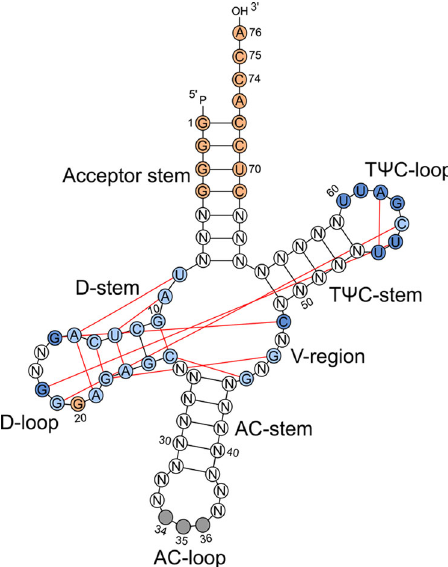
Fig. 1 Nonsense suppressor tRNA design. Fixed nucleotides in the design: AlaRS recognition (orange); anticodon (gray); tertiary interactions (red lines) between nts in t1 and t2 (dark and light blue) and in t3 – t5 (light blue). N denotes sites optimized to fi t to L-shaped tRNA structure. Different tRNA regions are designated. AC,